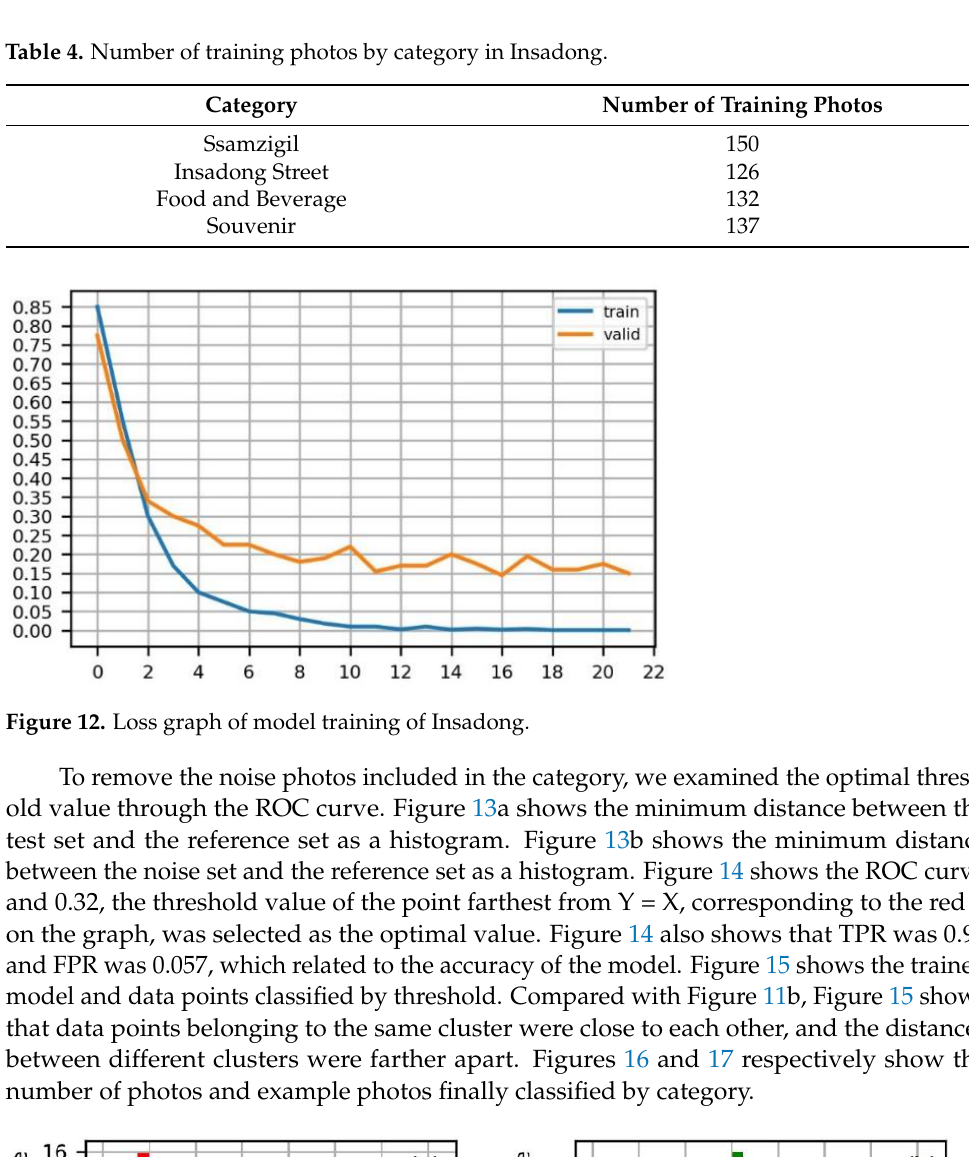
Figure 13. Histogram of Insadong: ( a ) minimum distance between a target photo set and reference set; ( b ) minimum distance between a noise photo and reference set.